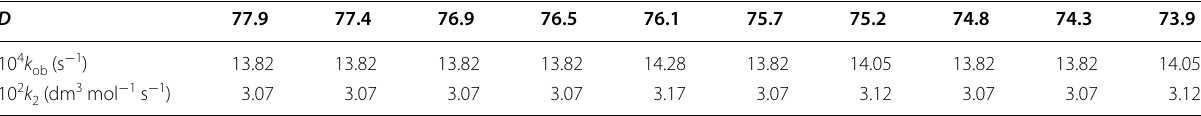
(paoH) ] 2 − with ATH 2 2